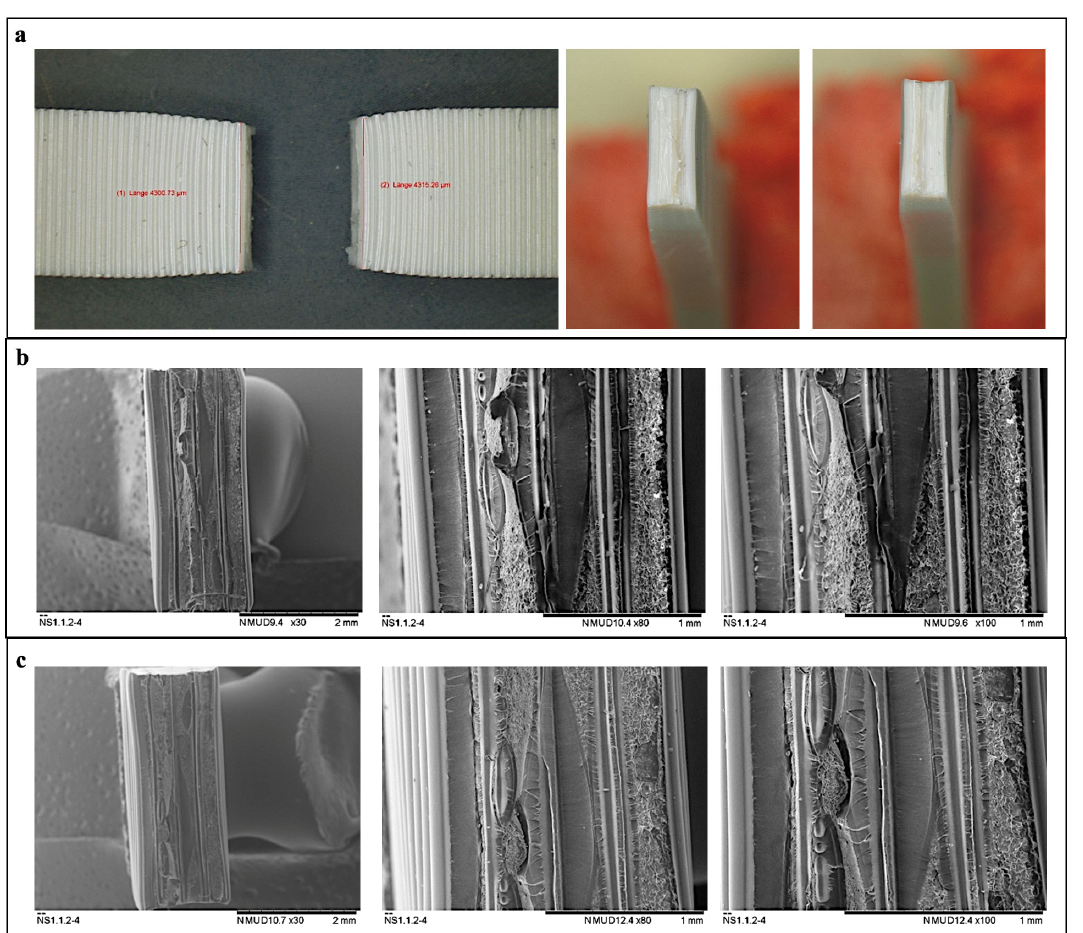
Figure 9. Visualization of both fracture sites of a sample using ( a ) light microscopy and ( b , c ) SEM.